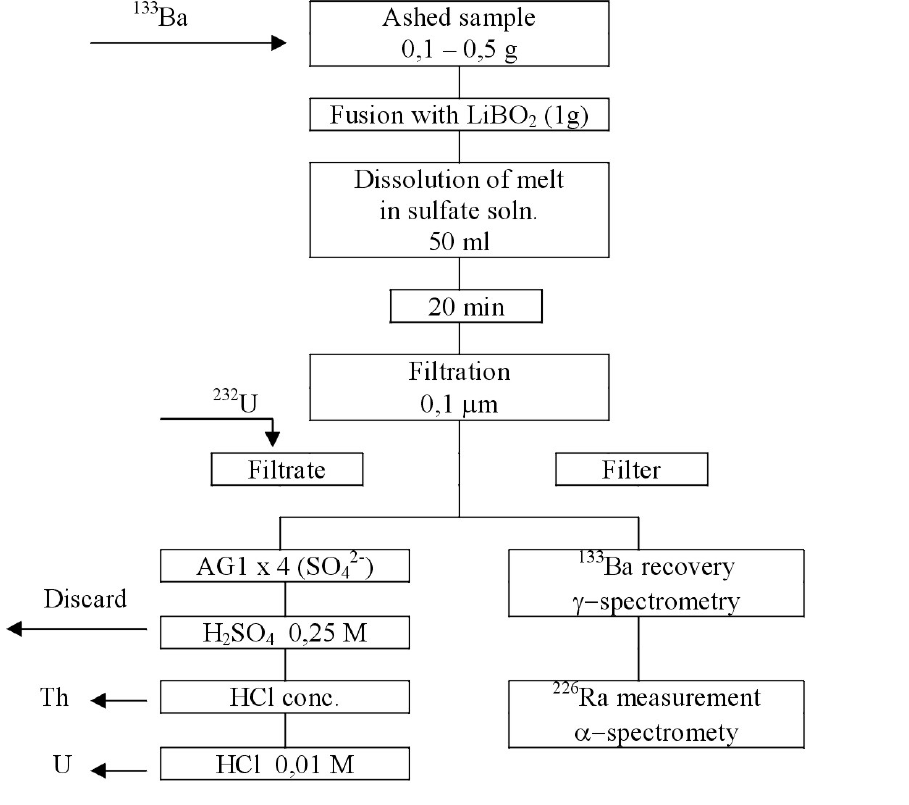
FIGURE 1 . Analytical scheme for the determination of 226 Ra and uranium